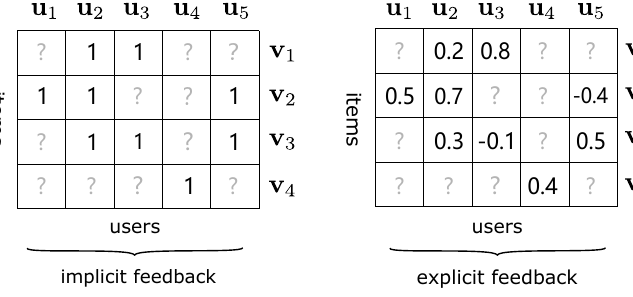
Figure 1. A simple example about a rating matrix under different